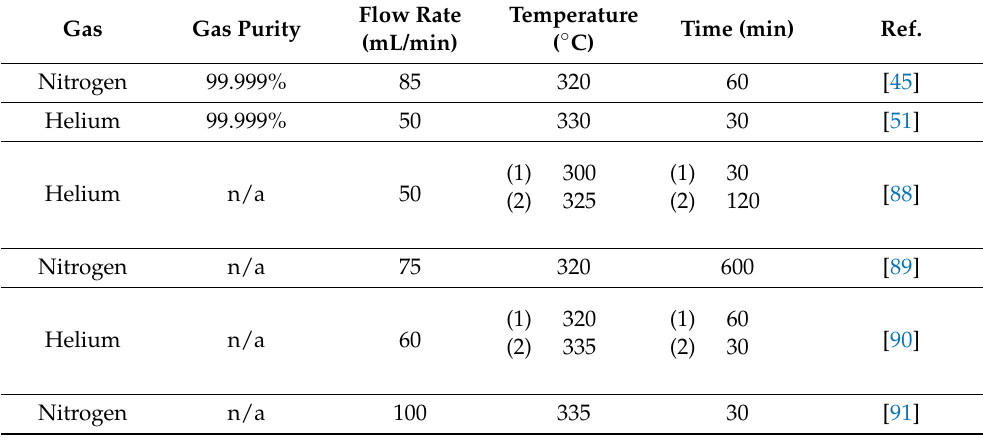
Table 5. Commonly employed conditions for thermal desorption tube